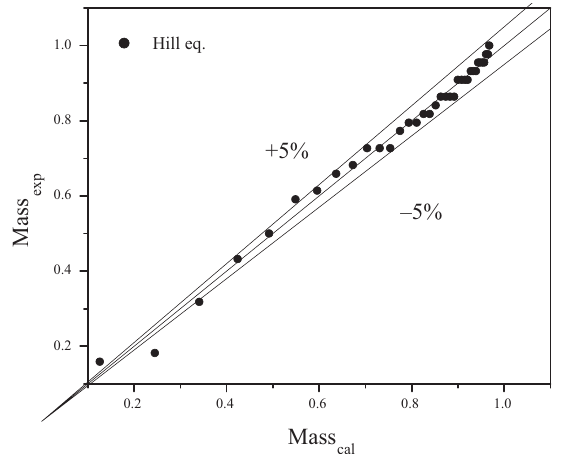
Fig. 14. Correlation between experimental values (mass calculated (mass ) by means of the Hill equation for the oil cal imbibition